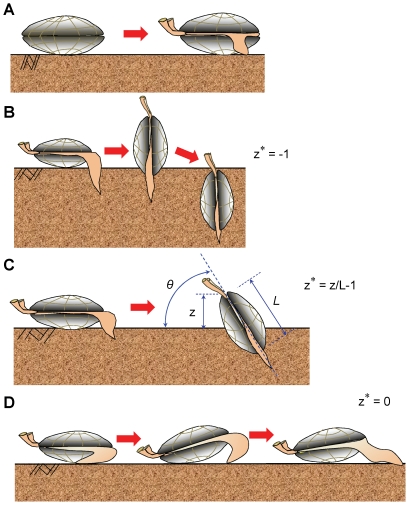
Definition of burrowing behavior for Ruditapes philippinarum and Donax semigranosus.(A) Starting condition for each individual in the burrowing experiments. (B) Observed typical processes of complete vertical burrowing. (C) Definition of normalized burrowing depth z* and burrowing angle θ, showing the state of inclined and partial burrowing. (D) Observed typical processes where burrowing was impossible, showing bending of foot and rebounding from sediment surface. The bivalve shape represents that of Ruditapes philippinarum.